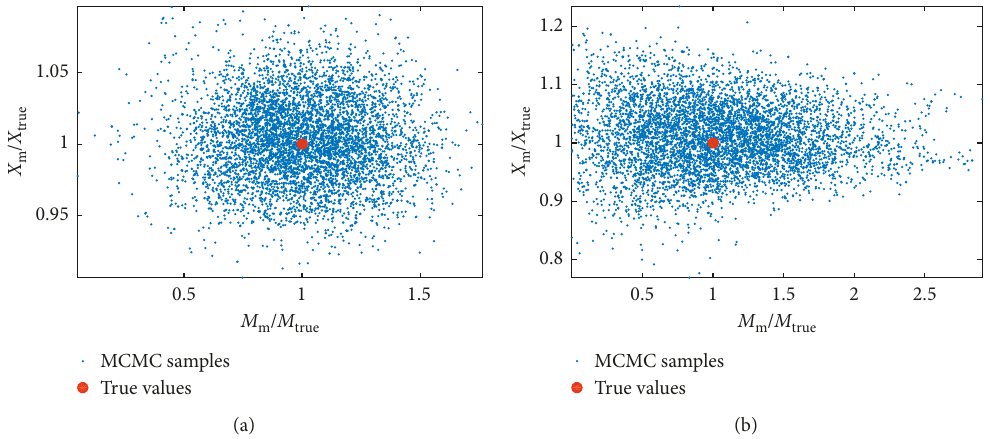
Figure 6: Scatter plot of the scaled X